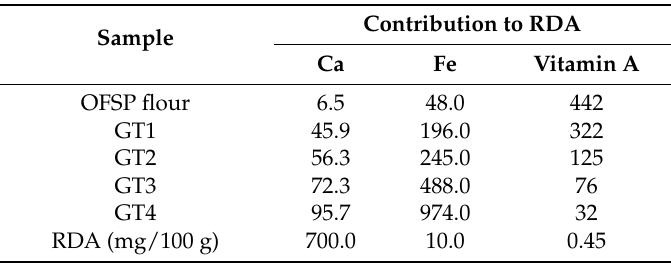
Table 5. Contribution (%) of calcium, iron and vitamin A of porridge from OFSP-based composite flours towards the RDA for children aged 6–59